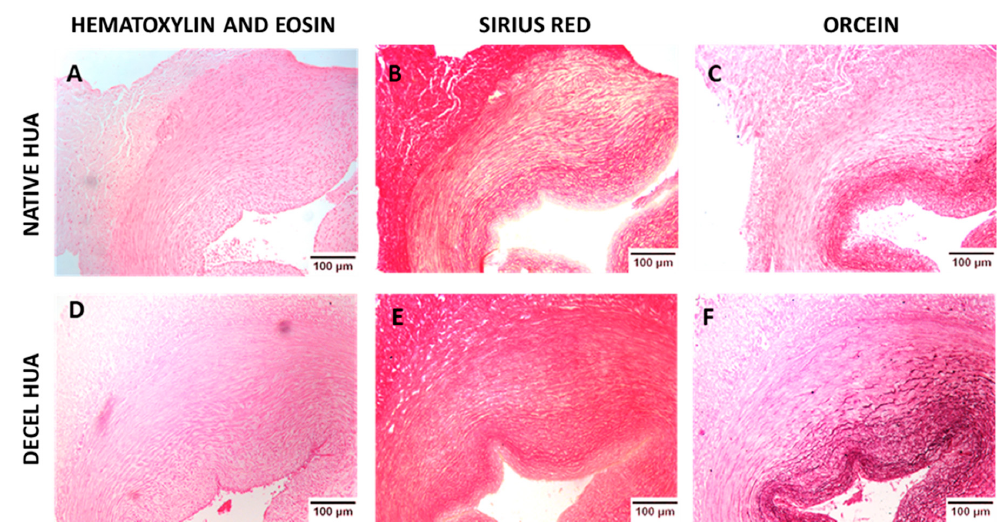
Figure 1. Histological analysis of human umbilical arteries (hUAs). Native hUA stained with Hematoxylin and Eosin (H&E) ( A ), Sirius Red (SR) ( B ), and orcein stain (OS) ( C ). Decellularized (Decel) hUA stained with H&E ( D ), SR ( E ), and OS ( F ). Images were obtained with original magnification 10× and scale bars 100 μ m.